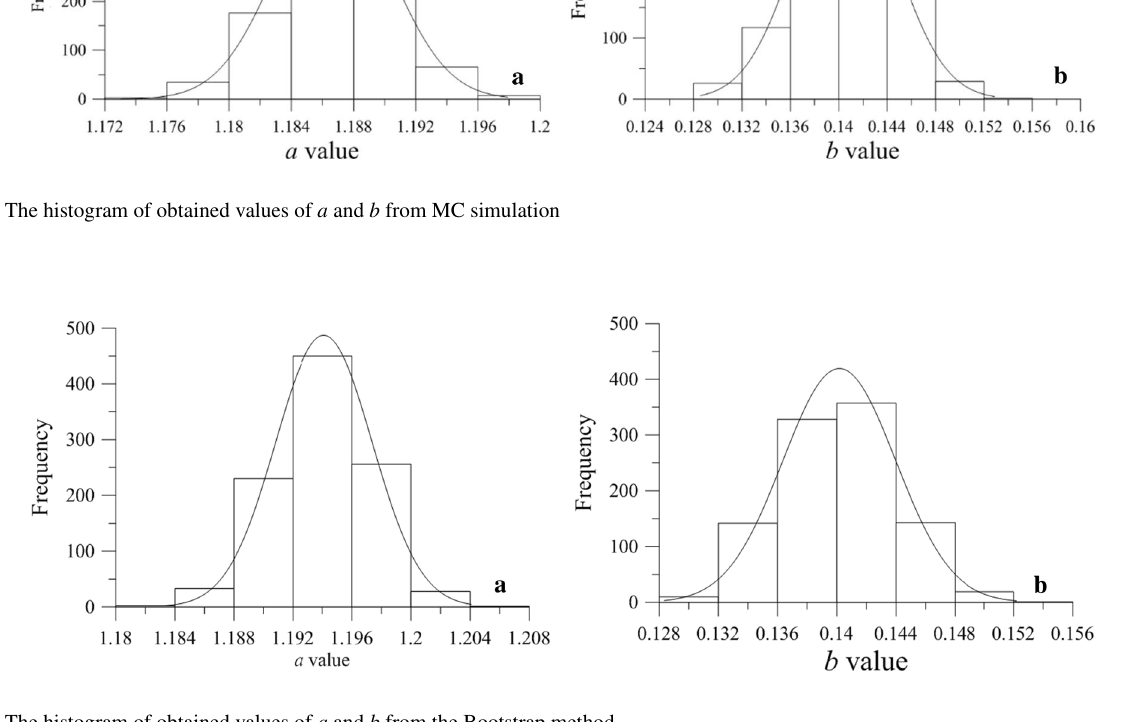
Fig. 7 The histogram of obtained values of a and b from the Bootstrap